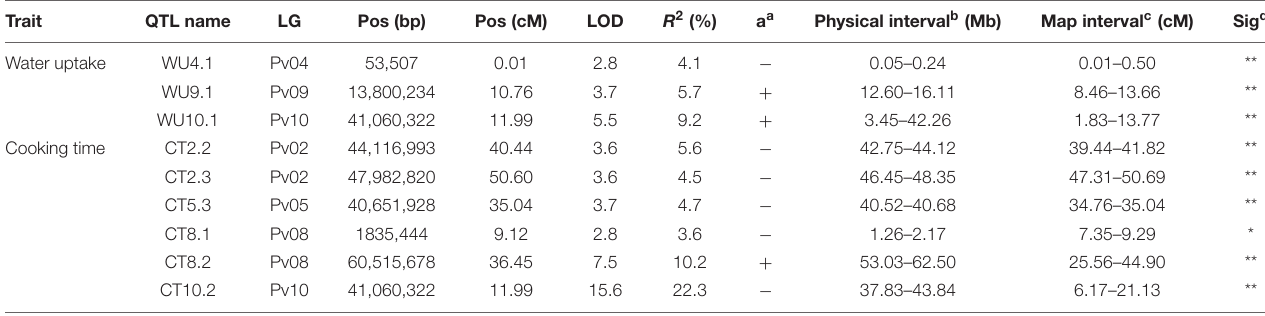
TABLE 3 | Quantitative trait loci identified in the RIL population ( N = 242) using BLUPs from samples grown in Entrican, MI in 2016 and 2017 for water uptake and cooking time. Trait